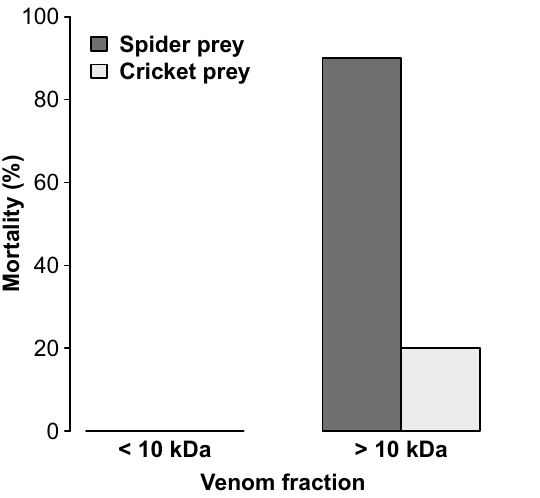
Figure 7. Comparison of the toxicity of venom fractions of Lampona spiders on two prey types measured 24 h after